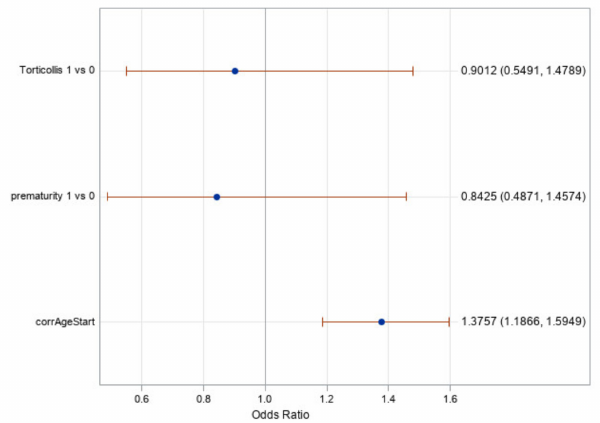
Figure 6. Odds ratios with 95% confidence intervals for torticollis, prematurity, and corrected age at start of